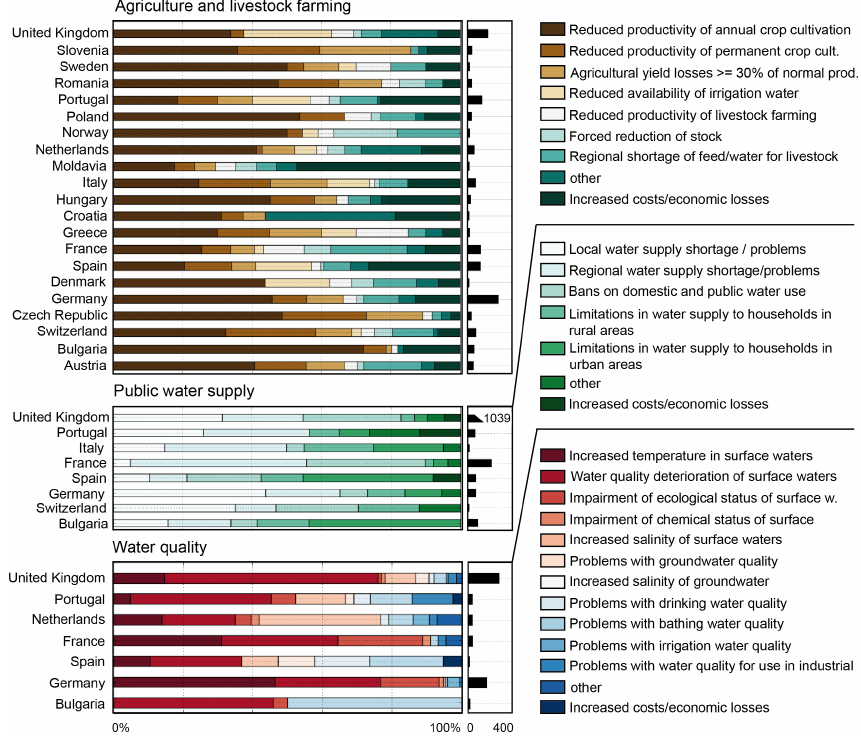
Figure 4. Reported impact types in three selected impact categories for countries with availability of > 15 reported drought impacts in the specific category. Impact type descriptions in the legend are shortened from Table